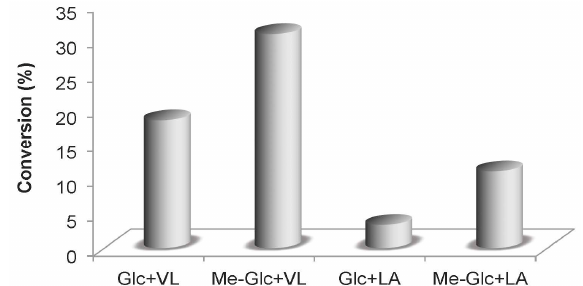
Figure 2. Comparison of the conversions obtained by transesterification and esterification with glucose and methyl glucoside as the co-substrates. Reaction conditions: 0.3 M of glucose (Glc) or methyl glucoside (Me-Glc), 0.3 M of vinyl laurate (VL) or lauric acid (LA), 100 mg of molecular sieve, 33.9 mg of Lipozyme TLIM, and 1 mL of 2M2B, 55 °C, 21 h.